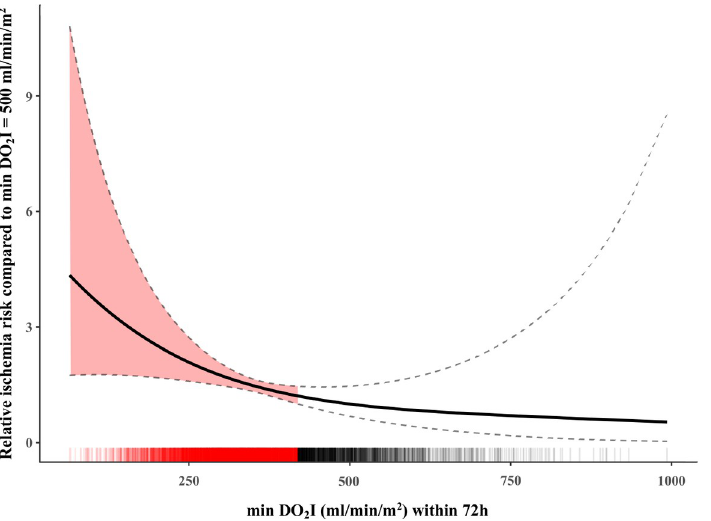
Fig 3. Relative ischemia risk compared to min DO 2 I within 72h before the onset of intestinal ischemia. Y-axis shows increasing relative ischemia risk with lower minDO 2 I values (x-axis, solid line) by DO 2 I values below approximately 400ml/min/m 2 (highlighted by the red marked area), dashed lines show the standard deviation, above the x-axis the 14.320 DO 2 I calculations are plotted as single small lines (critical DO 2 I values are highlighted as a red line), DO 2 I = oxygen delivery index, h =